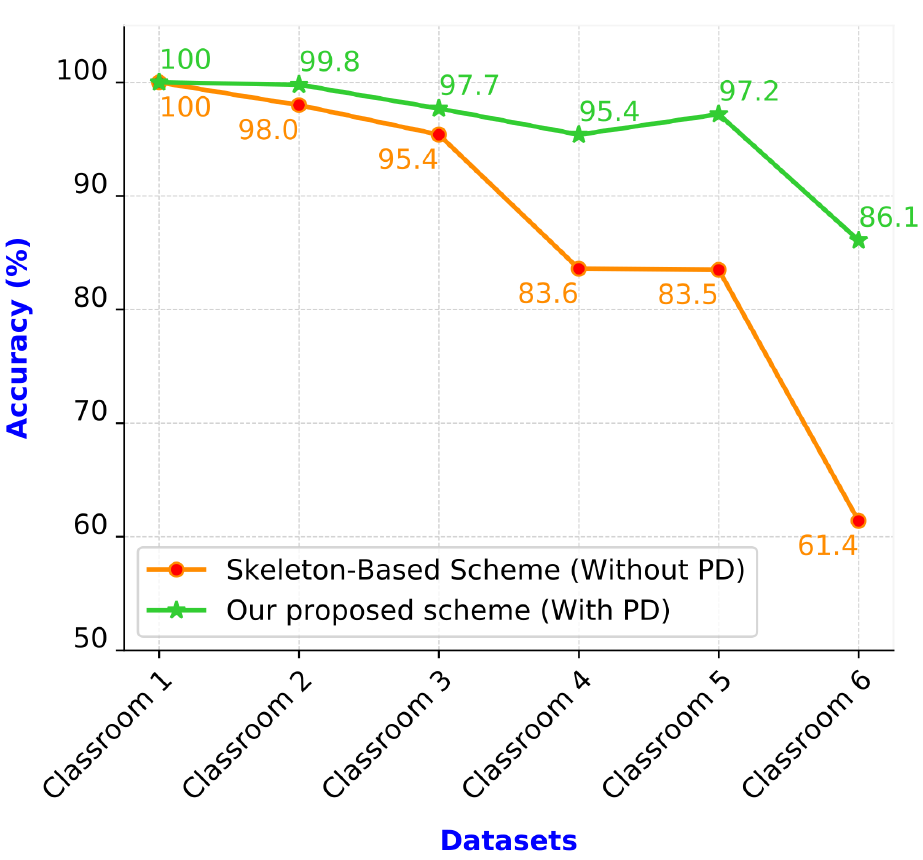
Figure 14. Results of people detection. Table 3. Results of the average processing